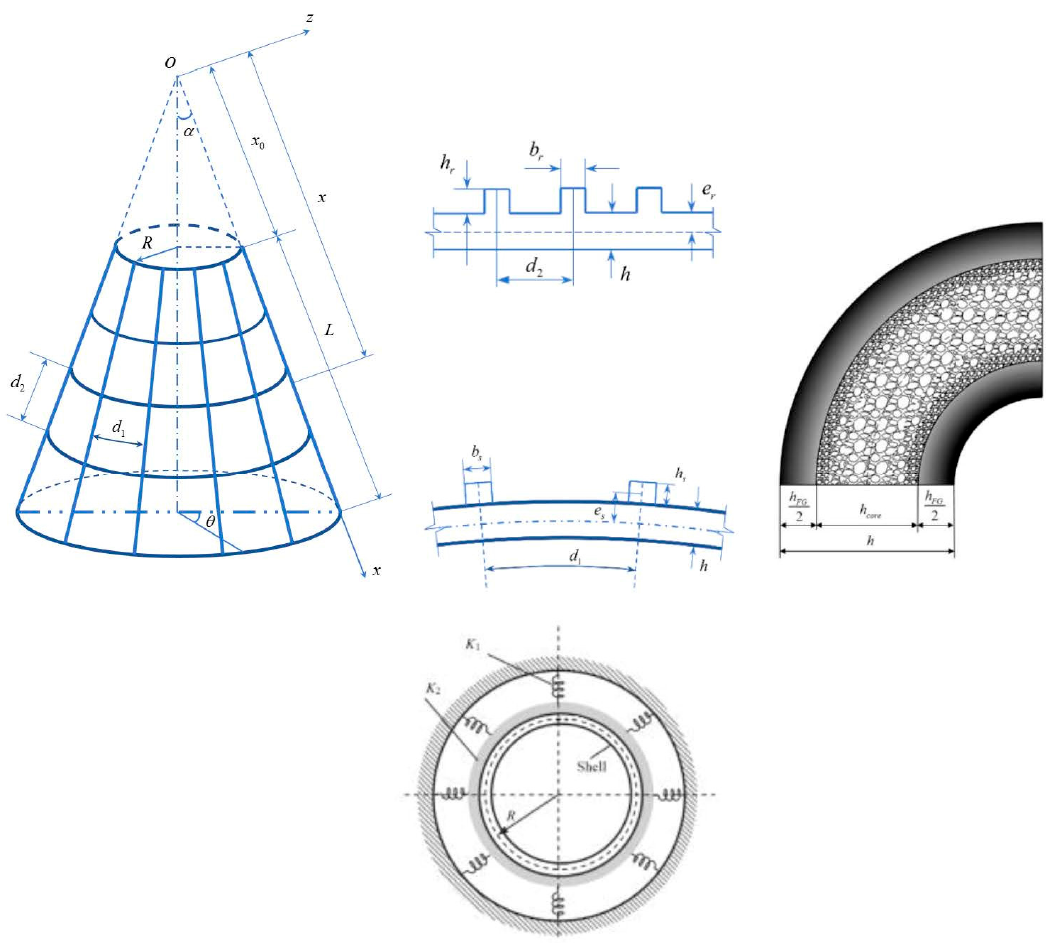
Figure 1. Geometry configurations and coordinates of the PSTC.